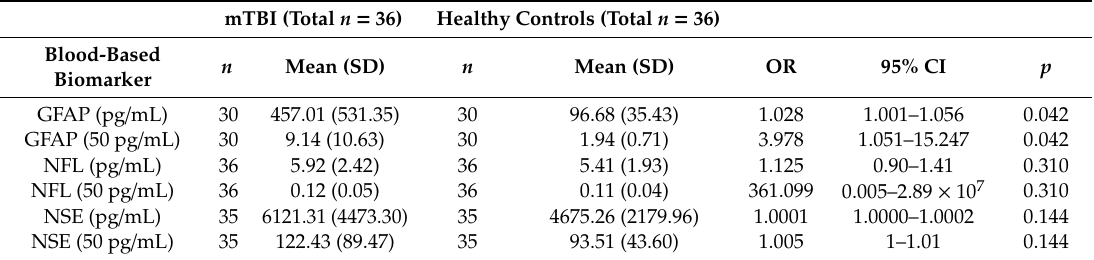
Table 4. Conditional logistic regression odds ratios for mTBI for blood-based biomarkers.